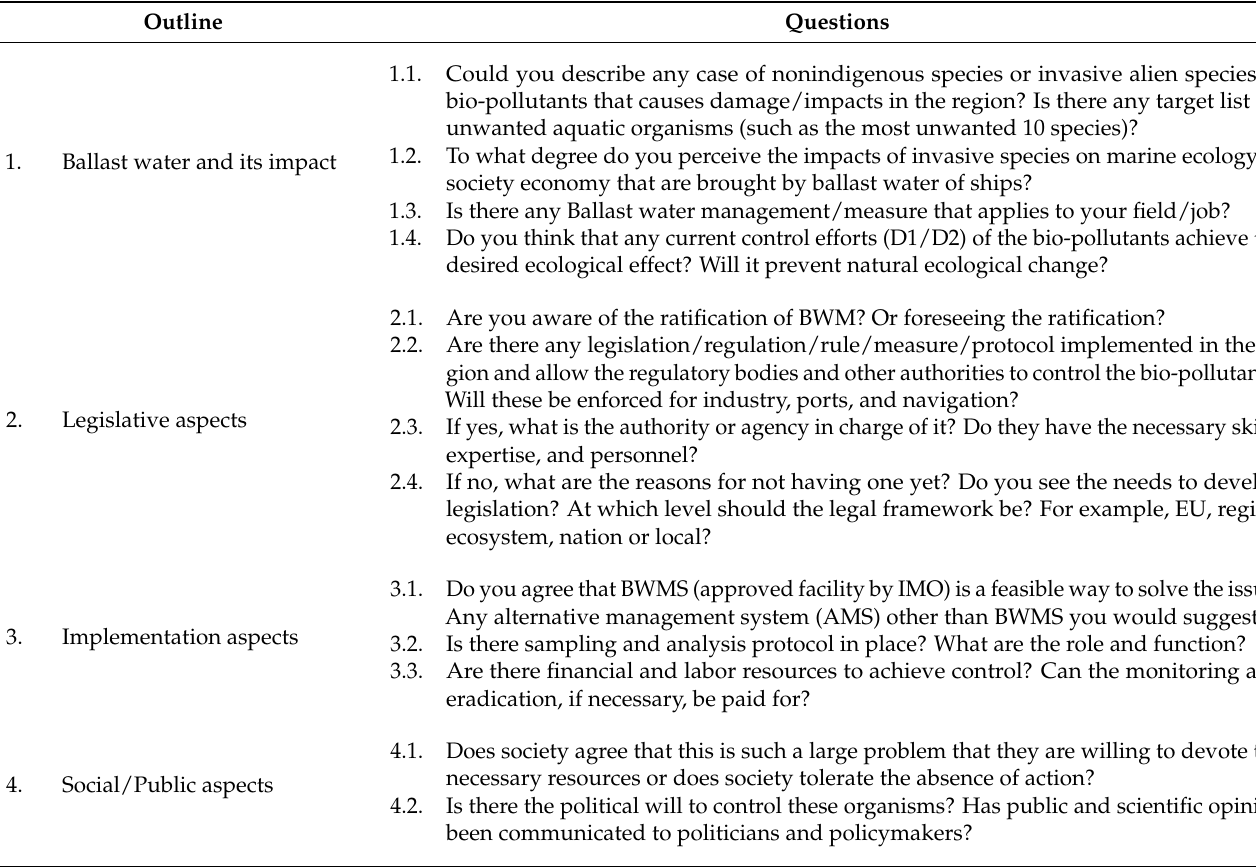
Table 1. The outline and questions for semi-structured